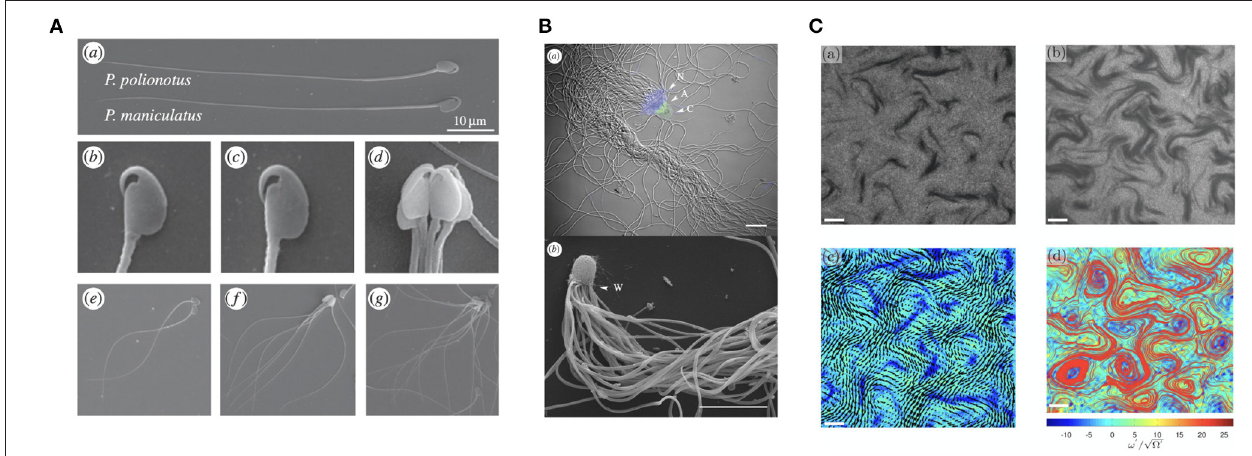
FIGURE 3 | Varieties of sperm collective behaviors. (A) A multiswimmer sperm train and the hook-like morphology of some murine spermatozoa. (B) Crowded sperm bundles of potentially hundreds of individual swimmers. (C) The emergence of sperm turbulence, found in dense suspensions. (A) is republished from Fisher et al. (2014), with permission under the terms of the Creative Commons Attribution License http://creativecommons.org/licenses/by/3.0/. (B) is republished with the permission of The Royal Society (U.K.) from Pearcy et al. (2014); permission conveyed through the Copyright Clearance Center, Inc. (C) is reprinted from Creppy et al. (2015) , Copyright (2019) by the American Physical